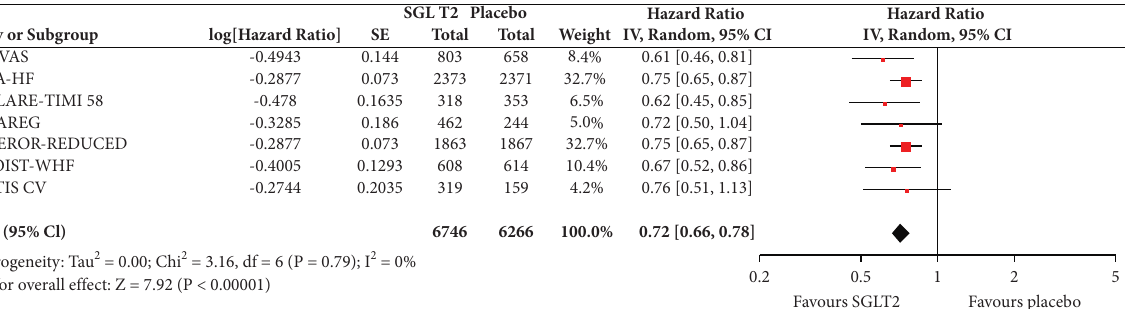
Figure 4: Effect of SGLT2 inhibitors versus placebo on hospitalisation for heart failure or cardiovascular death for the total population.